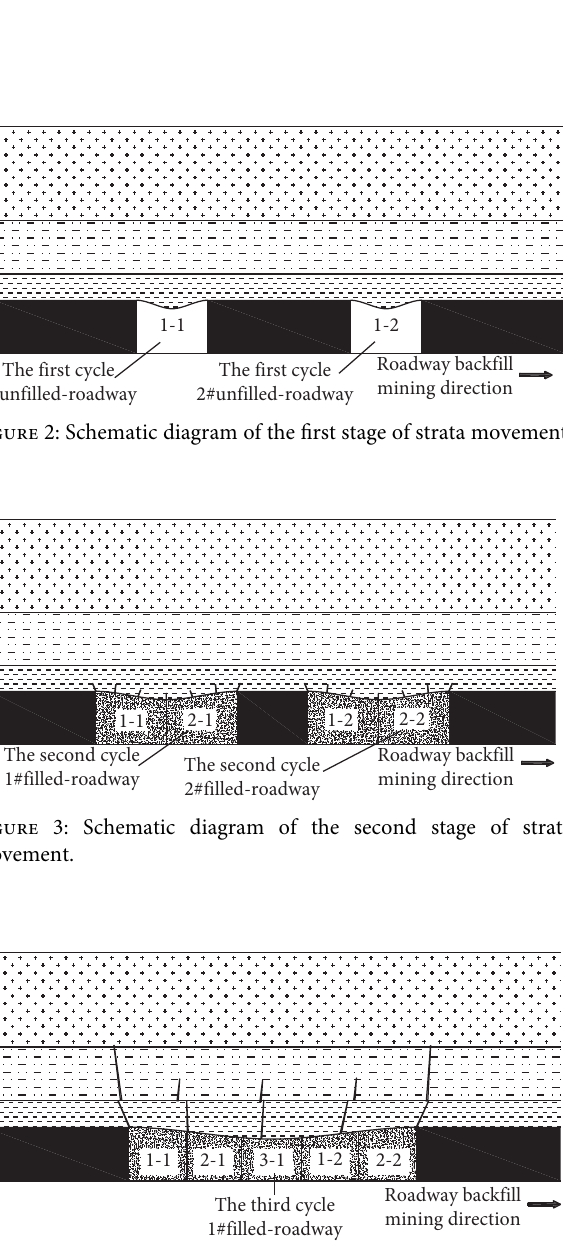
Figure 4: Schematic diagram of the third stage of strata movement.